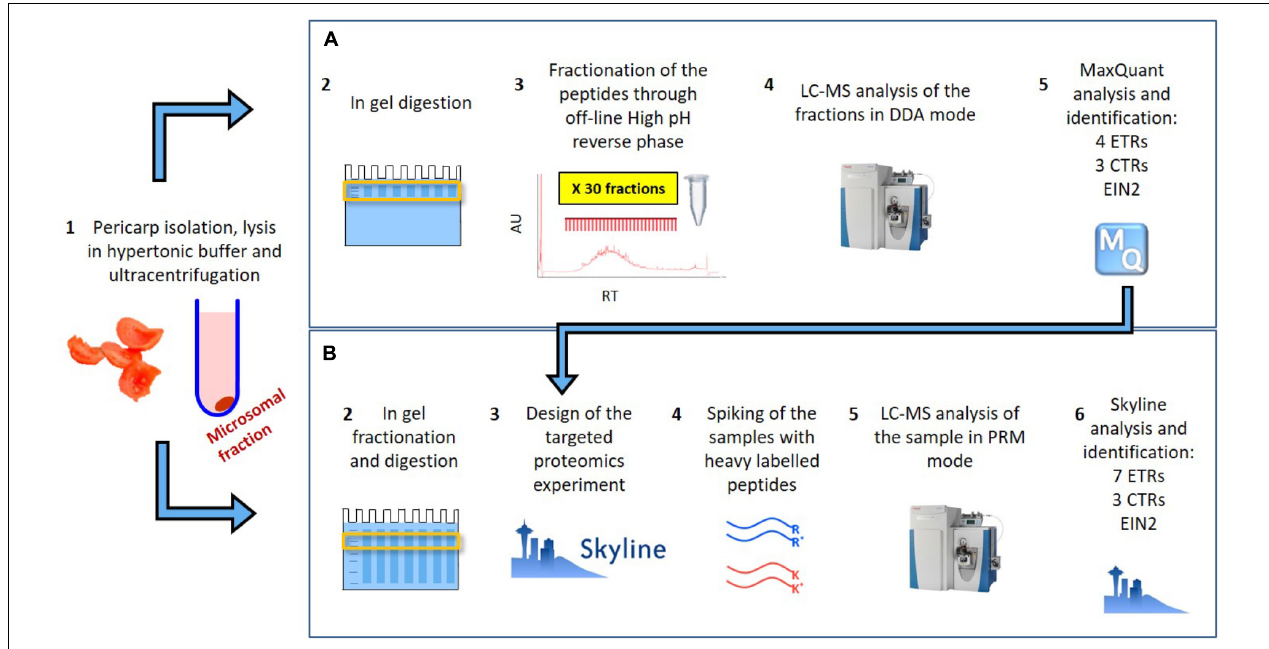
FIGURE 1 | Schematic representation of (A) the extensive fractionation analyzed though shotgun approach which allowed to identify 8588 proteins and between them 4 ETR, 3 CTR and EIN2 in tomato pericarp (Mata et al., 2017) and (B) the targeted proteomics approach followed in this work which allowed the identification and quantification of the 7 ETR, 3 CTRs and EIN2.